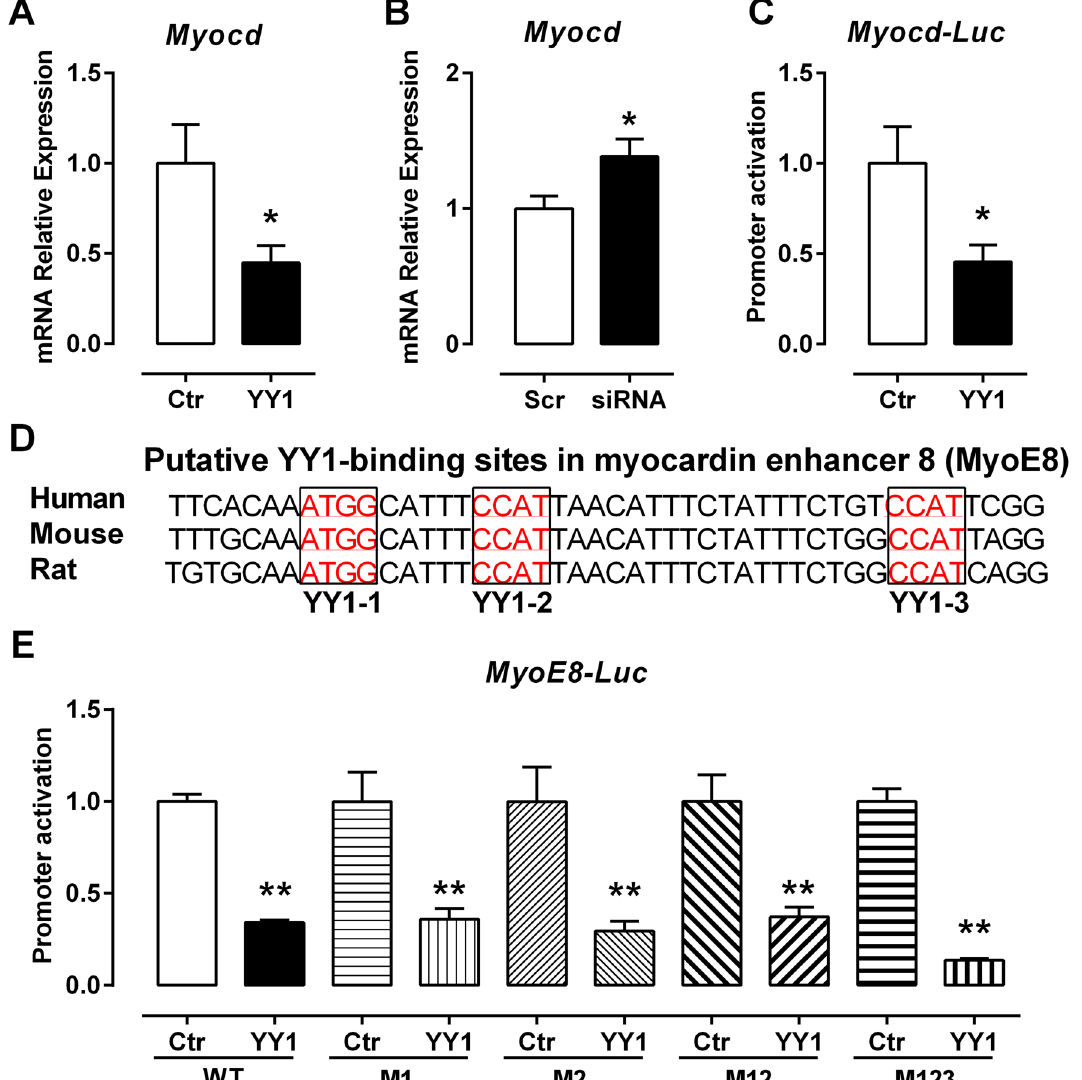
Figure 4. YY1 suppresses the transcription of myocardin in PAC1 cells. ( A,B ) By the qPCR assay, overexpression of YY1 downregulated the expression of Myocd mRNA while knockingdown YY1 by YY1 siRNA increased the expression of Myocd mRNA. ( C ) YY1 overexpression inhibited the Myocd promoter activity by the luciferase assay. ( D ) Three conserved putative YY1 binding sites (marked in red) were identified in the myocardin enhancer 8 (MyoE8) of human, rat and mouse. ( E ) YY1 overexpression suppressed the promoter activity of the wild type MyoE8 enhancer. Such repression could not be alleviated by mutation of each putative YY1 binding site individually or in combination. M1, M2, M12, and M123 indicate mutations of YY1 binding site YY1-1, YY1-2, both YY1-1/YY1-2, or all of three YY1 sites, respectively. Values are mean ± SEM (n = 3). * P < 0.05, ** P < 0.01 versus the control (Ctr, or